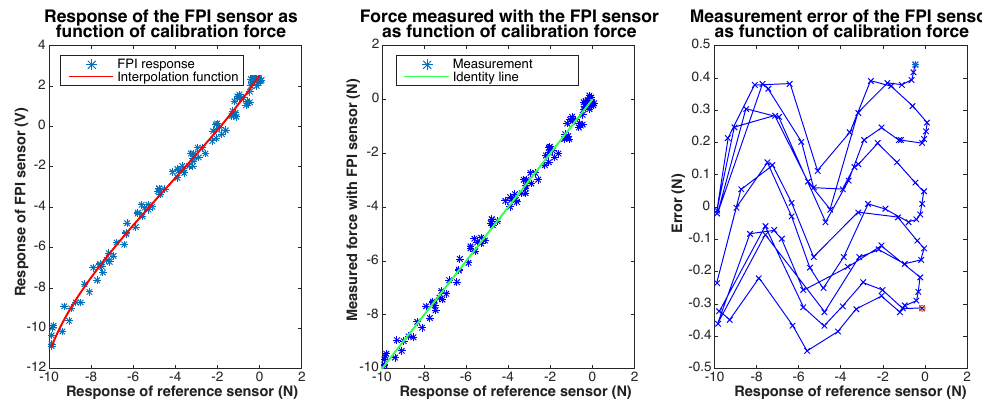
Figure 11. Results of static calibration of a prototype of the Invar capillary concept, not accounting for transverse force on the needle tip. The response of the FPI as function of the calibration force, together with a ploynomal fit, is shown on the left. The graph in the center shows the force measured with the FPI, calculated using the interpolation function, as function of the calibration force and the indentity line ( y = x ) as a reference. The measurement error of the FPI-based sensor as function of the calibration force is shown on the right.